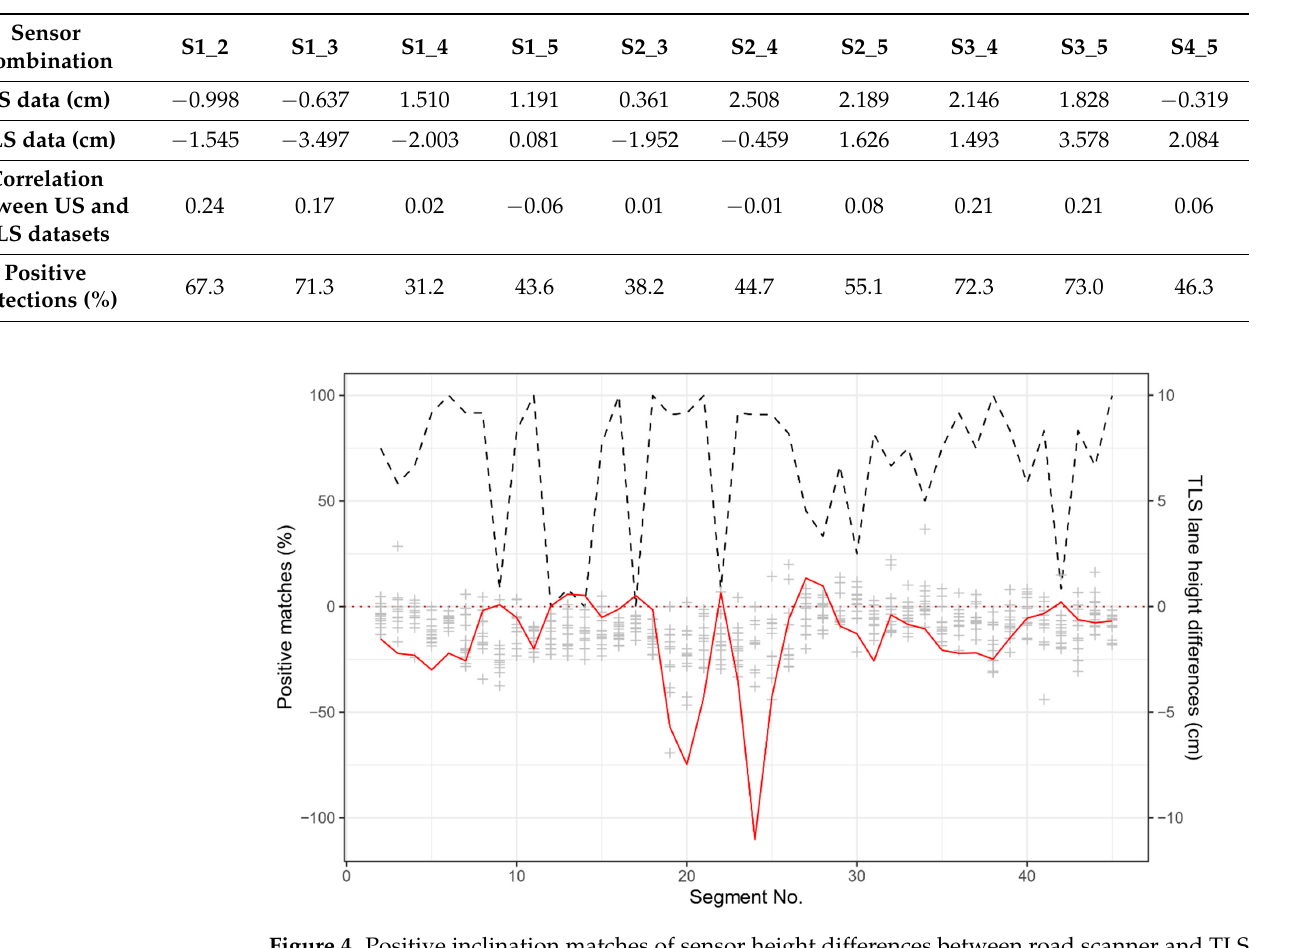
Figure 4. Positive inclination matches of sensor height differences between road scanner and TLS data, per repetition and segment (dashed line), including the absolute height difference (cm) derived from the TLS data (red) and from the road scanner data (grey crosses) for sensor combination S1_2 (mean dz TLS = − 1.54 cm, dz US = − 1.00 cm with 67.3% detection rate).